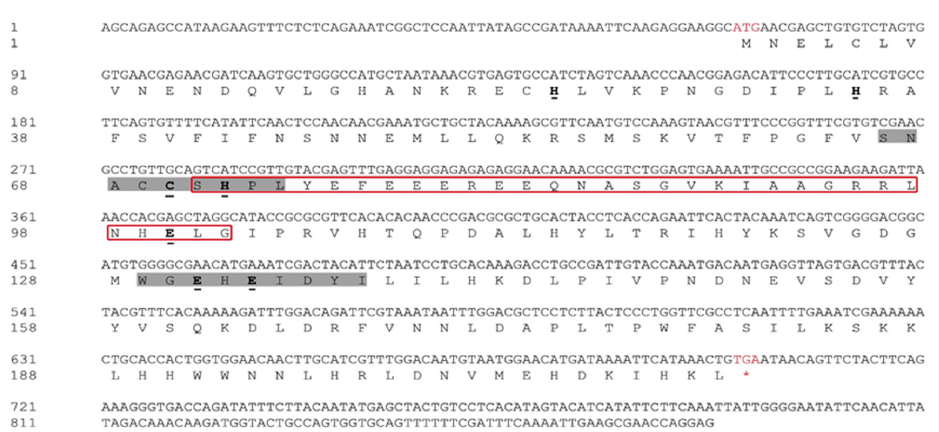
Figure 1. Nucleotide and amino acid sequence analysis of SfIPPI in S. furcifera . Red font ATG, start codon; red font TGA with an asterisk, stop codon; red box, Nudix hydrolase domain; bold and underlined amino acids, residues critical for the catalytic activity of the enzyme; amino acids with a shaded background, conserved cysteine and conserved glutamic acid motifs.